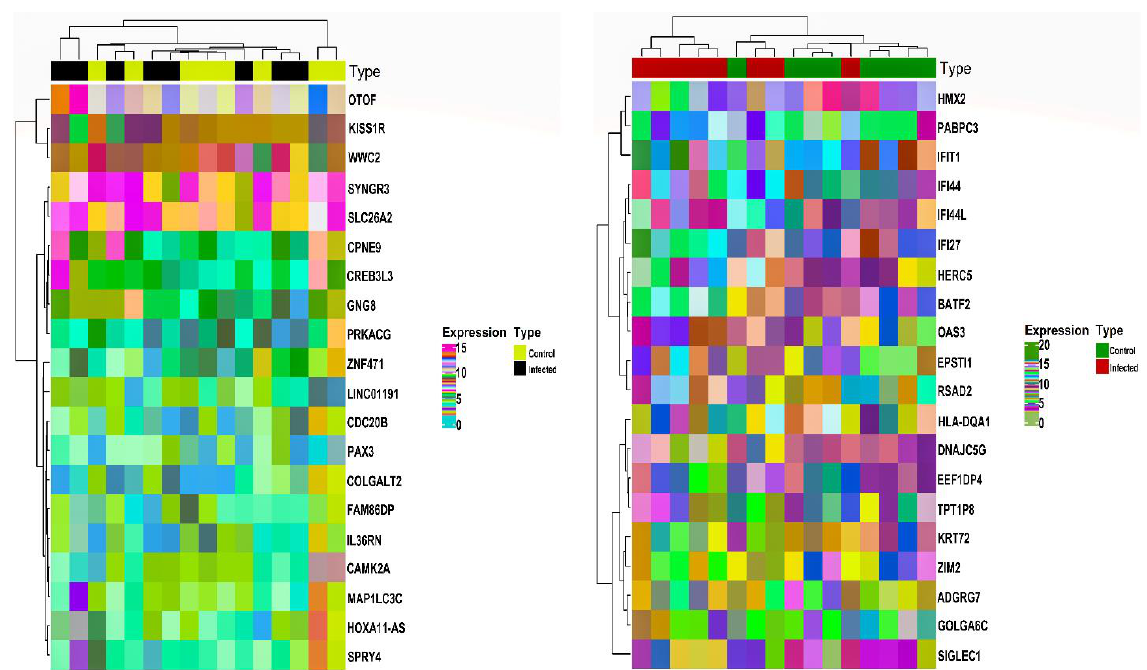
Figure 1. Annotation heatmap displays the distribution (expression) of the top 10 down and upregulated DEGs in the case of Mo (left panel) and WB (right panel). The cluster dendrograms signifying the Euclidean distance-based hierarchical clustering for both rows and columns are shown along the left and top sides of the plot. Sample type annotation bar is shown at the top of the heatmap. DEGs, Differentially Expressed Genes; Mo, Monocytes; WB, Whole Blood.